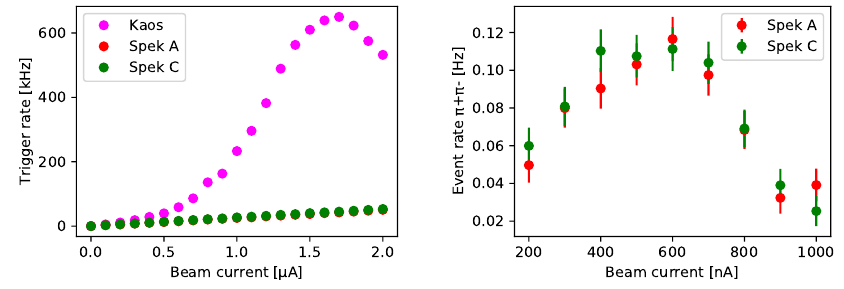
Figure 6. Rate study with the three spectrometers. Left: Trigger rate of the three spectrometers. While A and C are comparably low and continuously rising with the beam current, K AOS sees far more particles leading to a saturation of the trigger logic at around 1.6 µ A before the rates drop even lower. Right: Rate of true particle coincidences of K AOS with A or C. Here, after a linear increase, a maximum at 600nA can be seen. This is due to growing track reconstruction ambiguities with higher particle multiplicities in K AOS